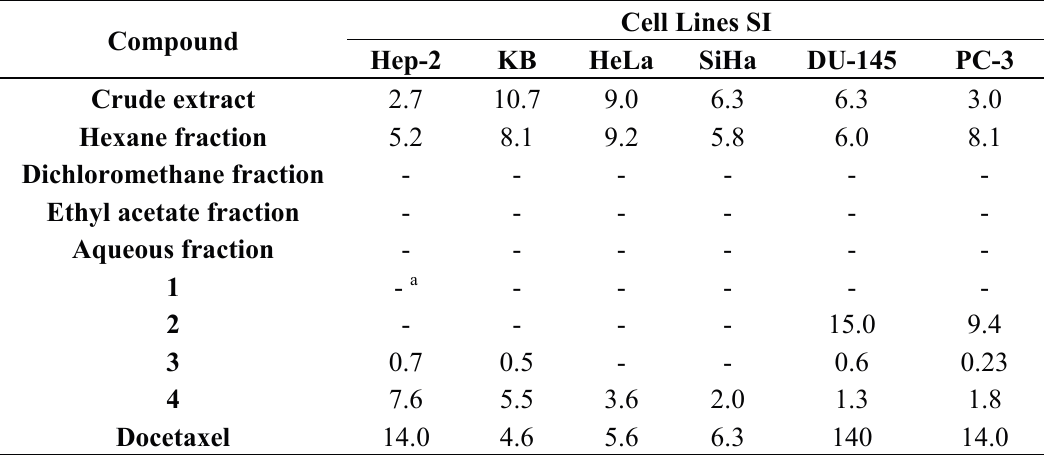
Table 3. Selectivity index (SI) of cytotoxic activity of compounds isolated from A. fascicularis root bark.